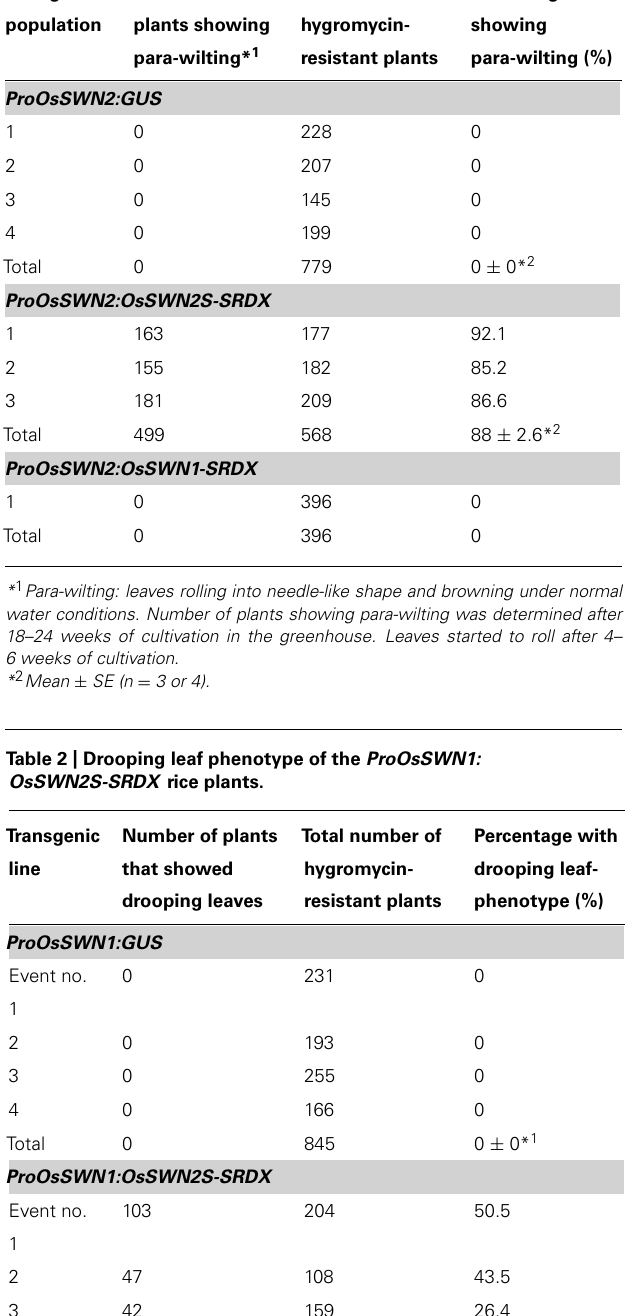
Table 1 | Para-wilting phenotype of the ProOsSWN2:OsSWN2S-SRDX rice plants. Transgenic